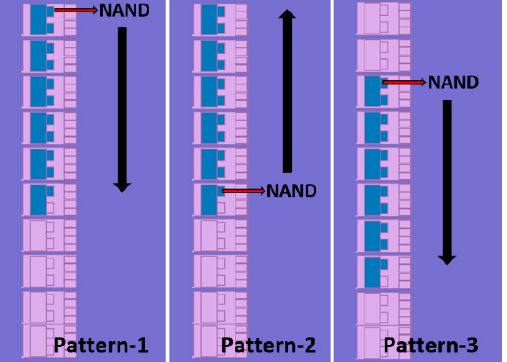
Figure 4. A rrangements of gates inside a LAB of Cyclone V-chip for 11-stage RO.